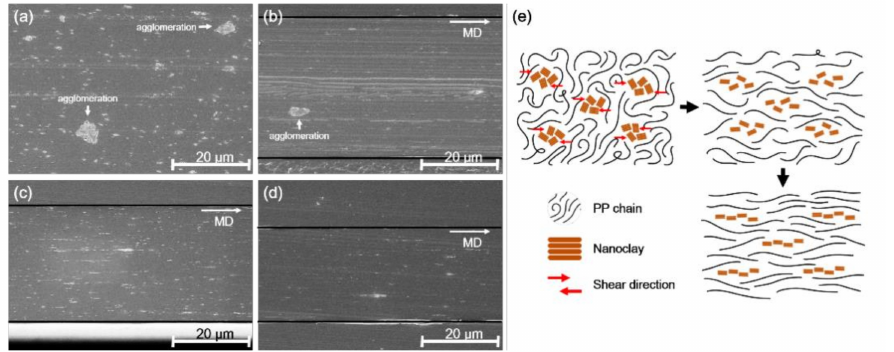
Figure 2. SEM micrographs of PP/nanoclay nanocomposite containing 2.0 wt% nanoclay according to the draw ratio: ( a ) × 1.0, ( b ) × 9.0, ( c ) × 13.5, ( d ) × 18.0, and ( e ) schematic presentation of overall morphology evolution for biaxially stretched PP/nanoclay